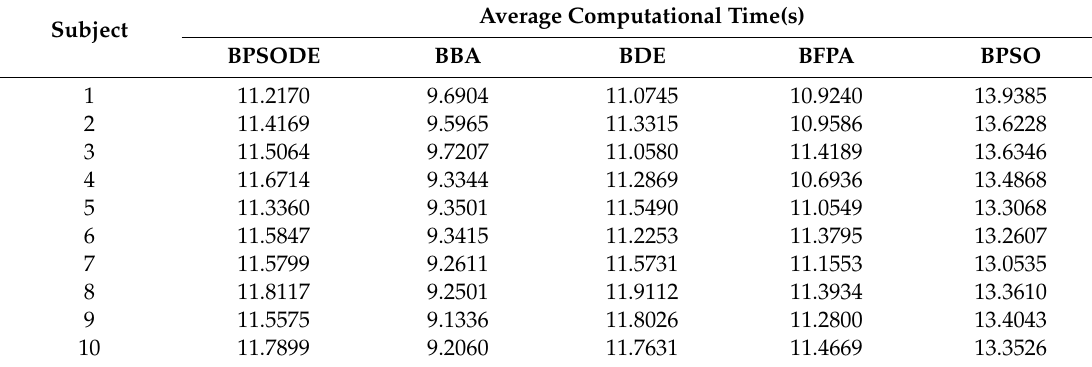
Table 4. Computational cost of the five different feature selection methods on 10 subjects.